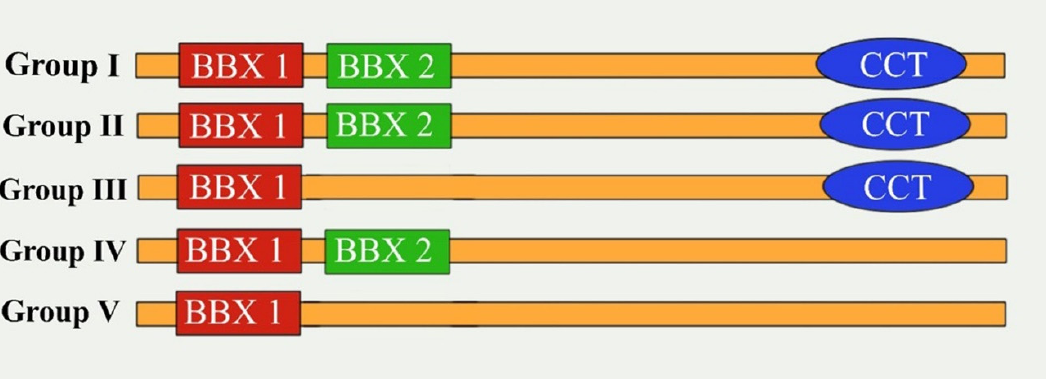
Figure 1. Scheme illustrating major features of BBX proteins in each structure group (Modified from Talar et al. [11]).